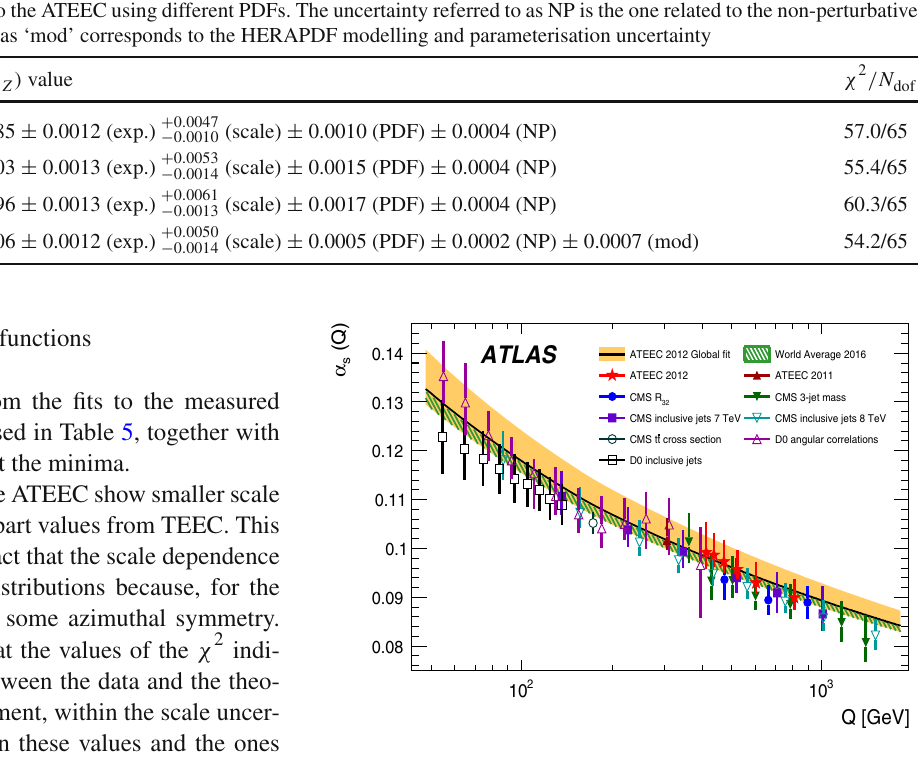
is smaller in ATEEC fits than in TEEC fits. The values of the χ 2 function at the minima show excellent agreement between the data and the pQCD